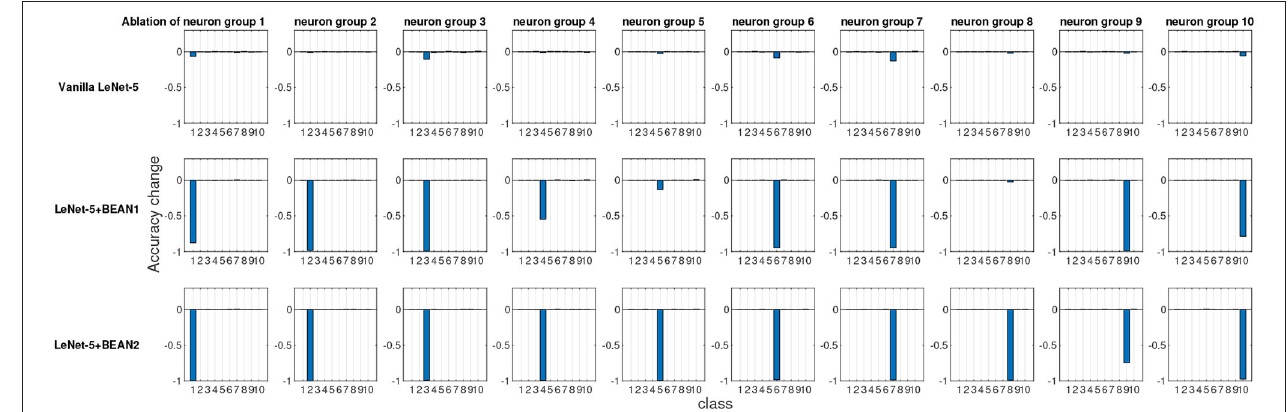
FIGURE 5 | The ablation study at the neuron population level of the last dense layer of LeNet-5 models. Each time, one distinct group of neurons were ablated based on their most selective class and the model performance changes for each individual class were recorded.